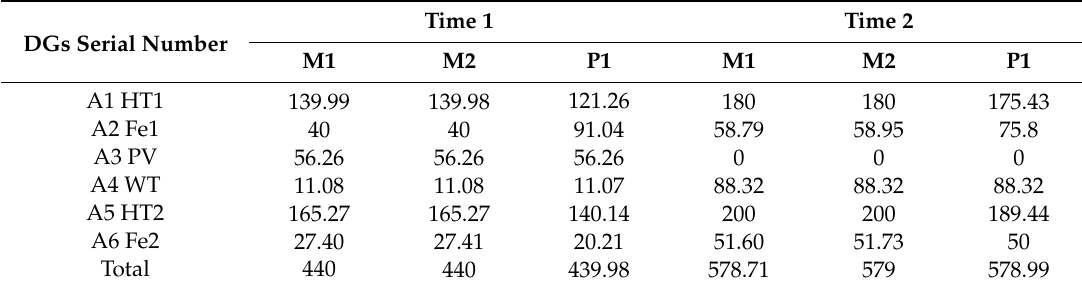
Table 2. Results comparison.